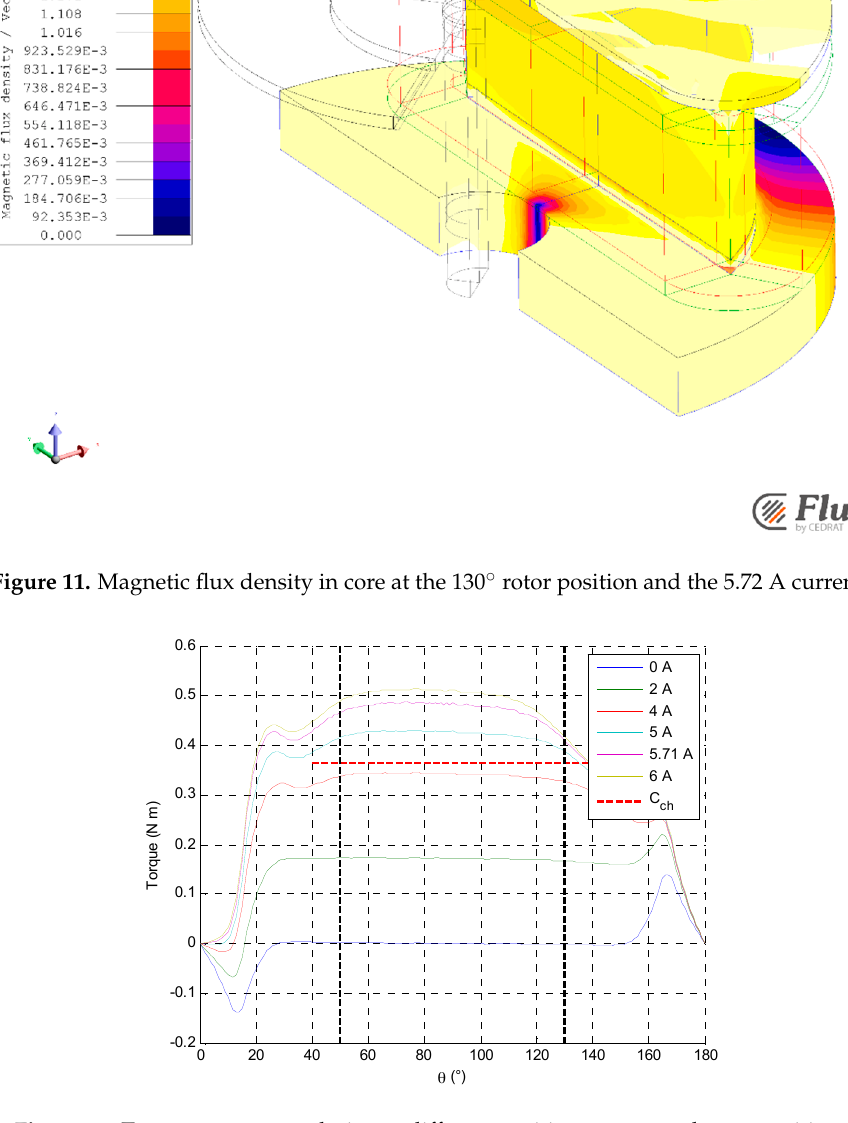
Figure 12. Torque actuator evolution at different positive current and rotor position.